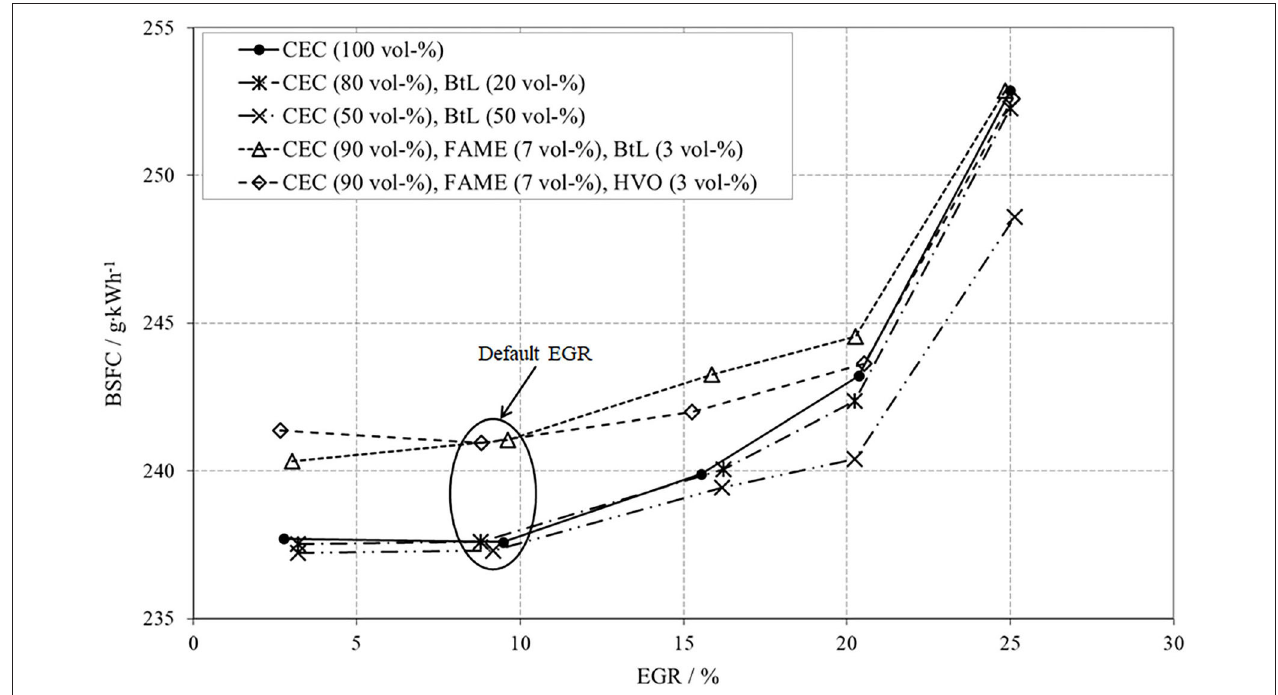
FIGURE 8 | BSFC at 1,500 min − 1 and 5 bar BMEP with varying EGR.